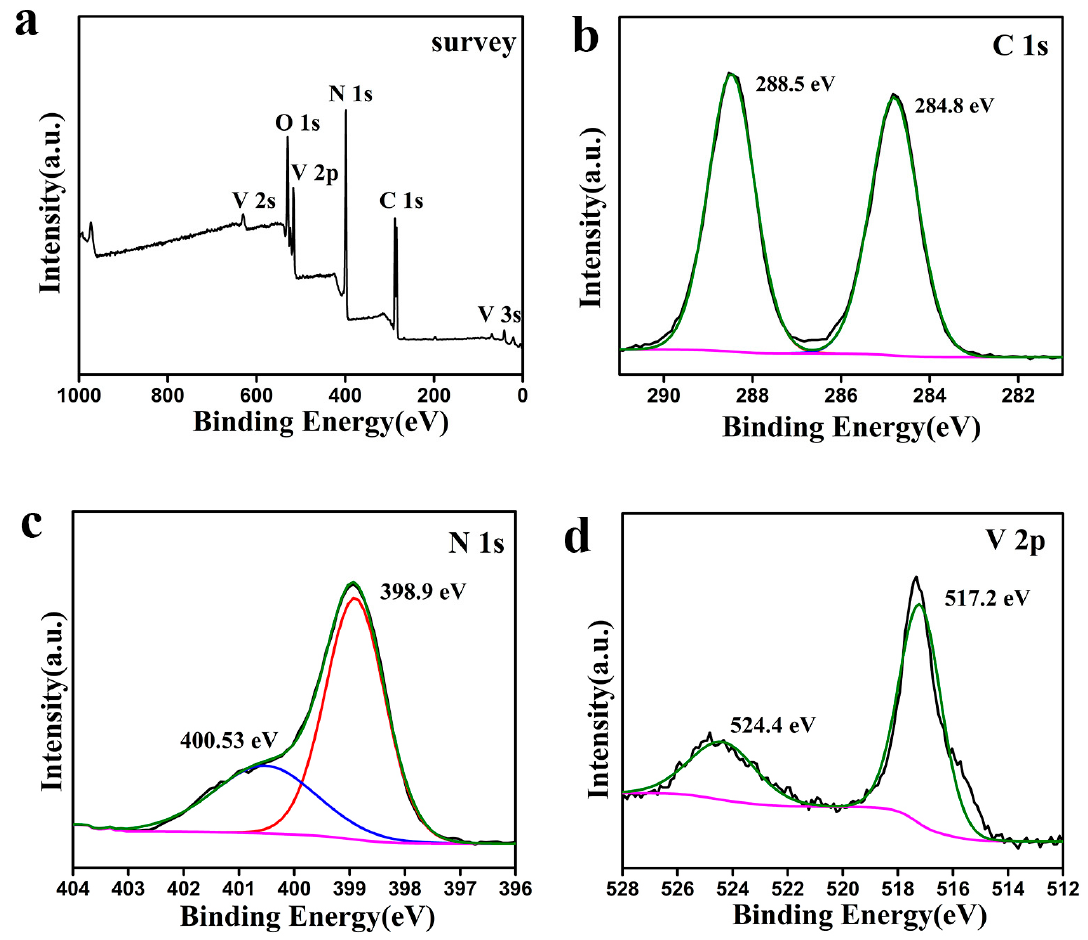
Figure 4. XPS spectroscopy of V-g-C 3 N 4 -0.5: survey spectra ( a ), C 1s ( b ), N 1s ( c ), and V 2p ( d ).